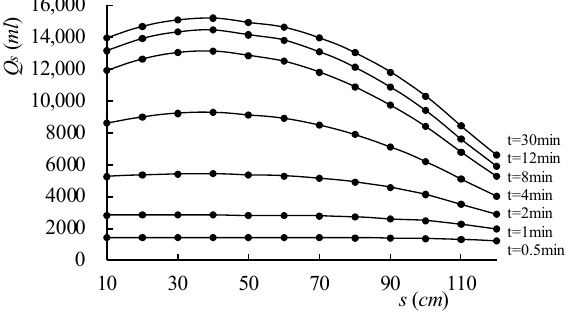
Figure 4. The effective storage capacity (ESC) ( Q s )—distance ( s ) relationship curves.